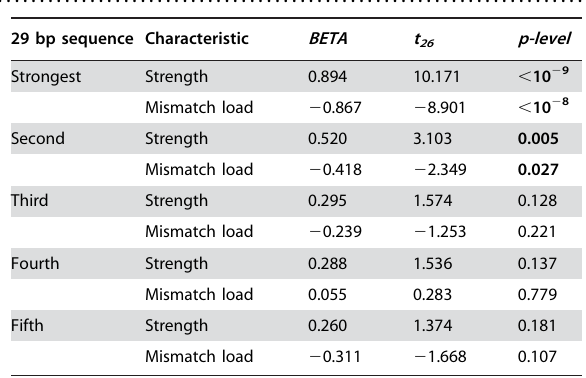
Table 3. Dependence of the uptake efficiency of the DNA fragments in [40] on the strength and mismatch load of their